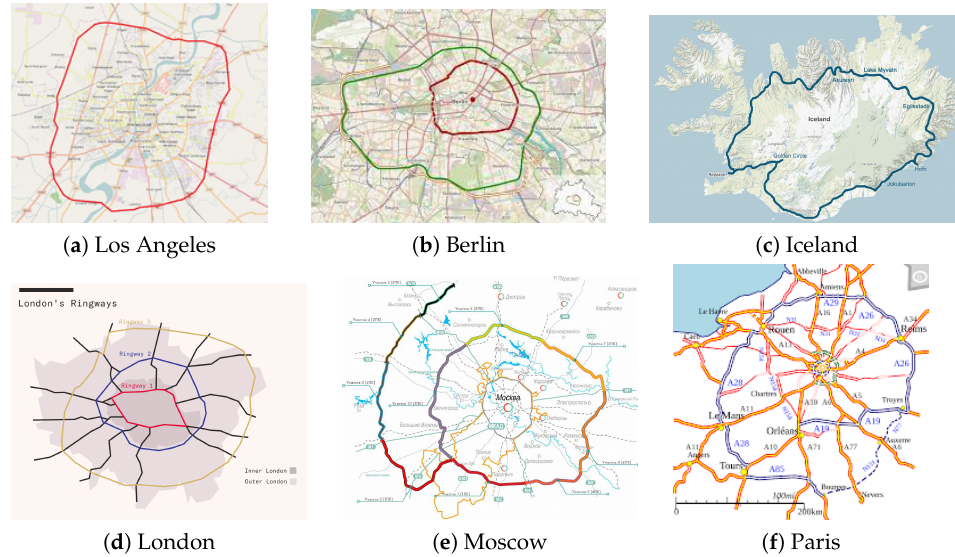
Figure 22. Peripheral roads of some major